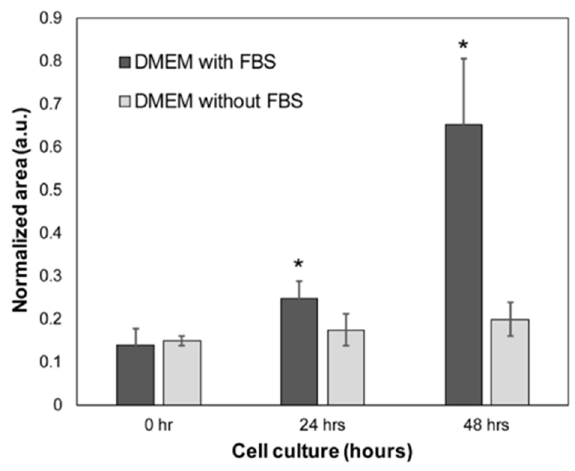
Figure 5. Quantitative analysis of cell migration. The captured images are quantified using ImageJ ( n = 4). The “filled-in” area is normalized to cell migration. The area covered by cells increases significantly after 24 h with FBS added culture media, arisen from cell migration. Without FBS, there are no significant changes in the measured area.